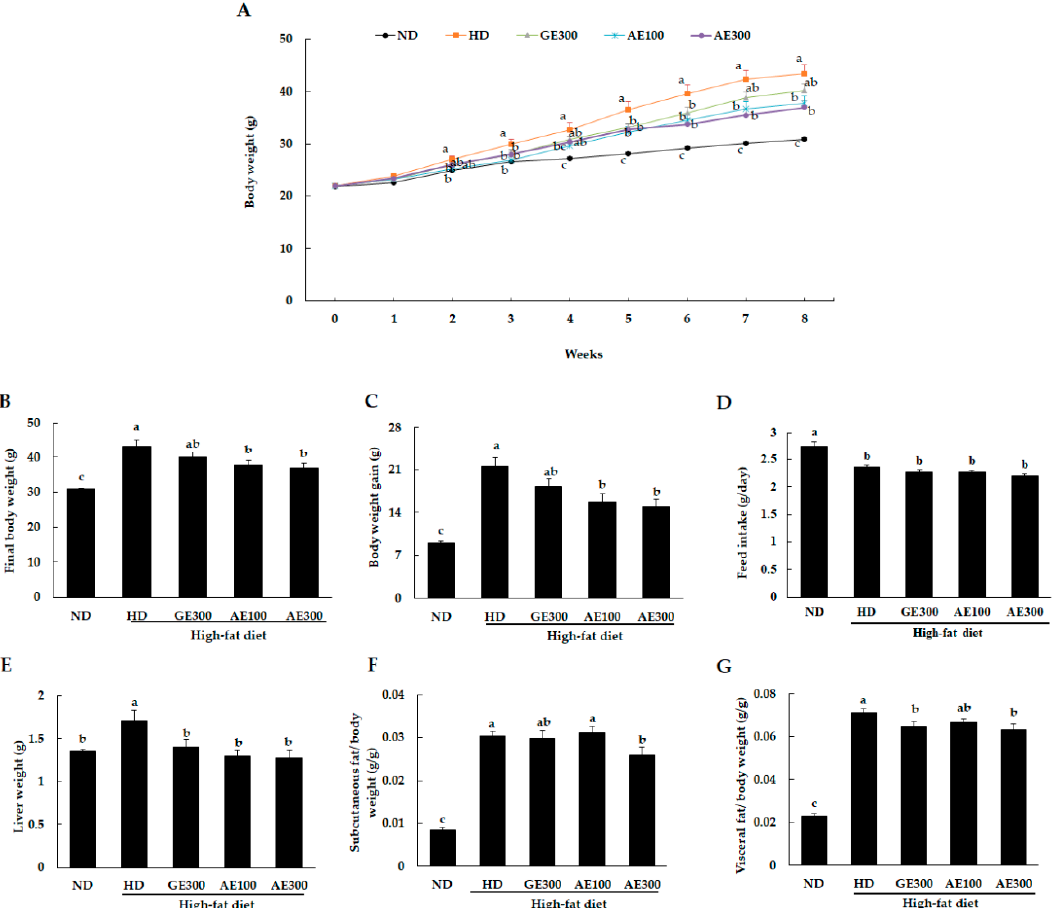
Figure 1. E ff ect of Abeliophyllum distichum extract (AE) on body weight and liver and fat weight in the experimental mice. Mice were fed a high-fat diet and orally administered a Garcinia extract (300 mg / kg b.w) or an A. distichum leaf extract at a low (100 mg / kg b.w) or at a high dose (300 mg / kg b.w) for 8 weeks. ( A ) Body weight during the experimental period, ( B ) final body weight, ( C ) body weight gain, ( D ) feed intake, ( E ) liver weight, ( F ) subcutaneous fat weight, and ( G ) visceral fat weight. ND, normal diet, HD, high-fat diet, GE300, high-fat diet + Garcinia 300 mg / kg b.w, AE100, high-fat diet + 100 mg / kg b.w, AE300, high-fat diet + 300 mg / kg b.w. Values are expressed as mean ± SEM, n = 10. The varying superscript letters indicate a statistically significant di ff erence among the groups by Duncan’s test of ANOVA, p < 0.05.